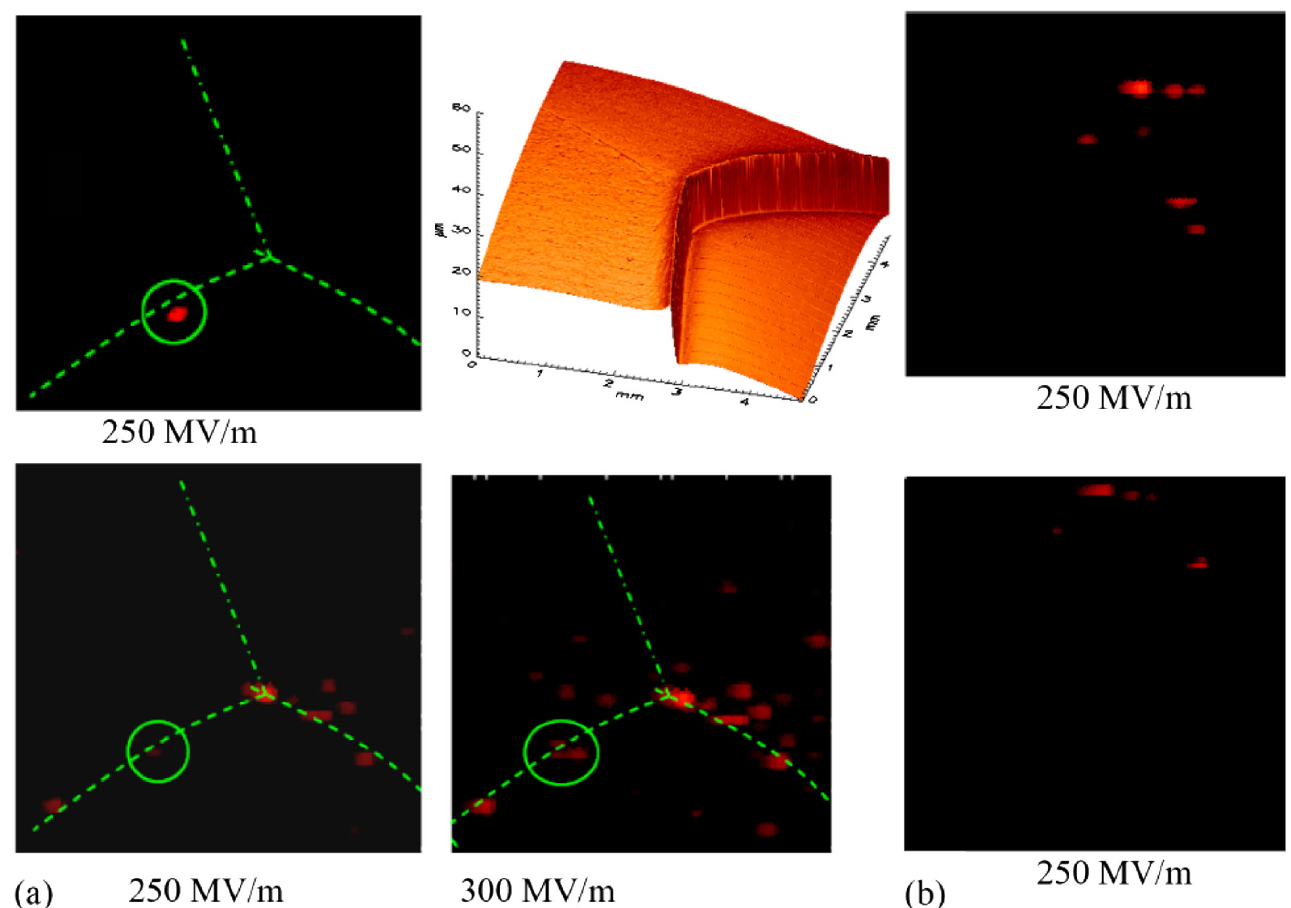
FIG. 4. (Color) (a) E maps of LGNb3, and surface profile showing grain boundaries. The encircled emitter is the one activated before HT, and dotted lines in the scan represent the grain boundaries. (b) E maps for SCNb4: the vertical shift of scans before and after HT is an experimental artifact. All the scans were made over the same area of ð 5 (cid:5) 5 Þ mm 2 , scanned before (upper) and after 150 (cid:2) C heat treatment (lower row) up to the given maximum fields. An anode of 100 (cid:1) m flat-apex diameter at the tip-to-sample distance of 20 ð 16 : 5 Þ (cid:1) m for 250 ð 300 Þ MV = m maximum field was used in these